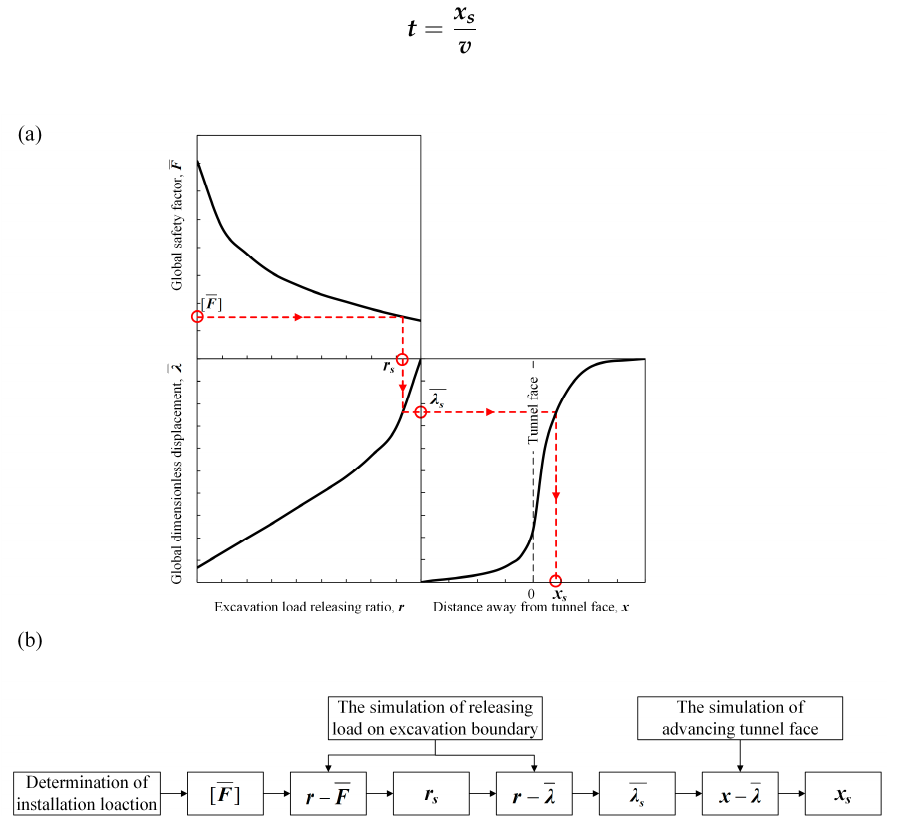
Figure 5. Flow diagram of the determination of installation time for the initial support: ( a ) detailed computational procedures, ( b ) graphical relationship between F and x .